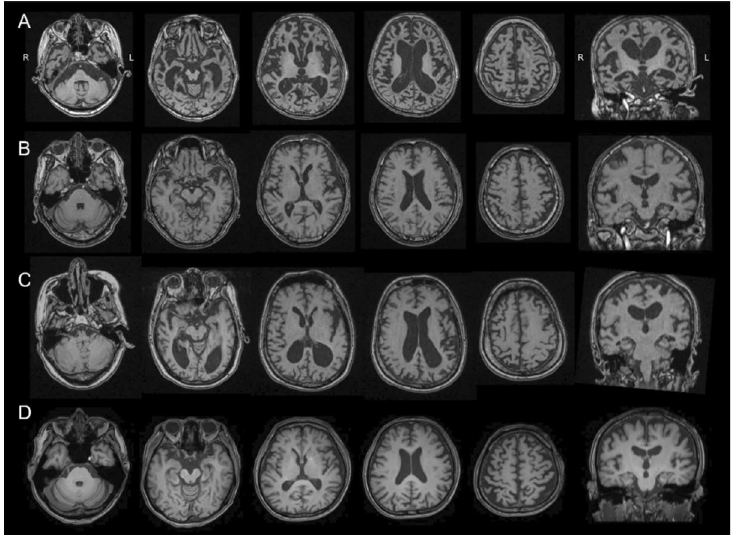
Figure 1. T1-weighted MRI scans of a patient with familial Alzheimer’s disease with Osaka mutation (FAD (Osaka)) ( A ); a patient with early stage sporadic Alzheimer’s disease (early SAD) ( B ); a patient with advanced stage of SAD ( C ); and a healthy control (HC) ( D ). The FAD (Osaka) patient had severely advanced brain atrophy including most of the cerebral cortex and brain stem. Parahippocampal atrophy and ventricular enlargement were prominent in the coronal section. The cerebellum and primary mortar cortex were relatively spared. R: right, L: left.